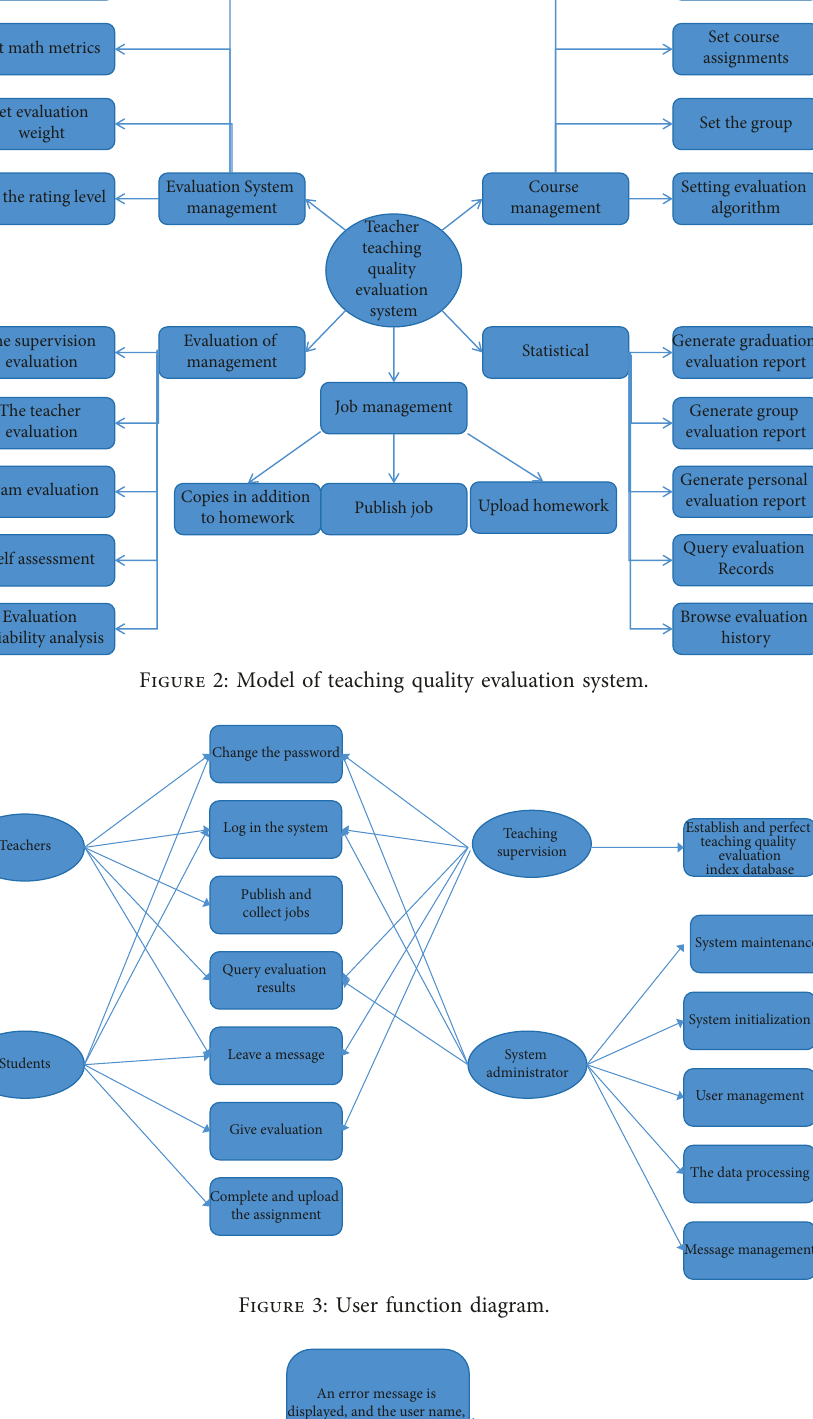
Figure 3: User function diagram.